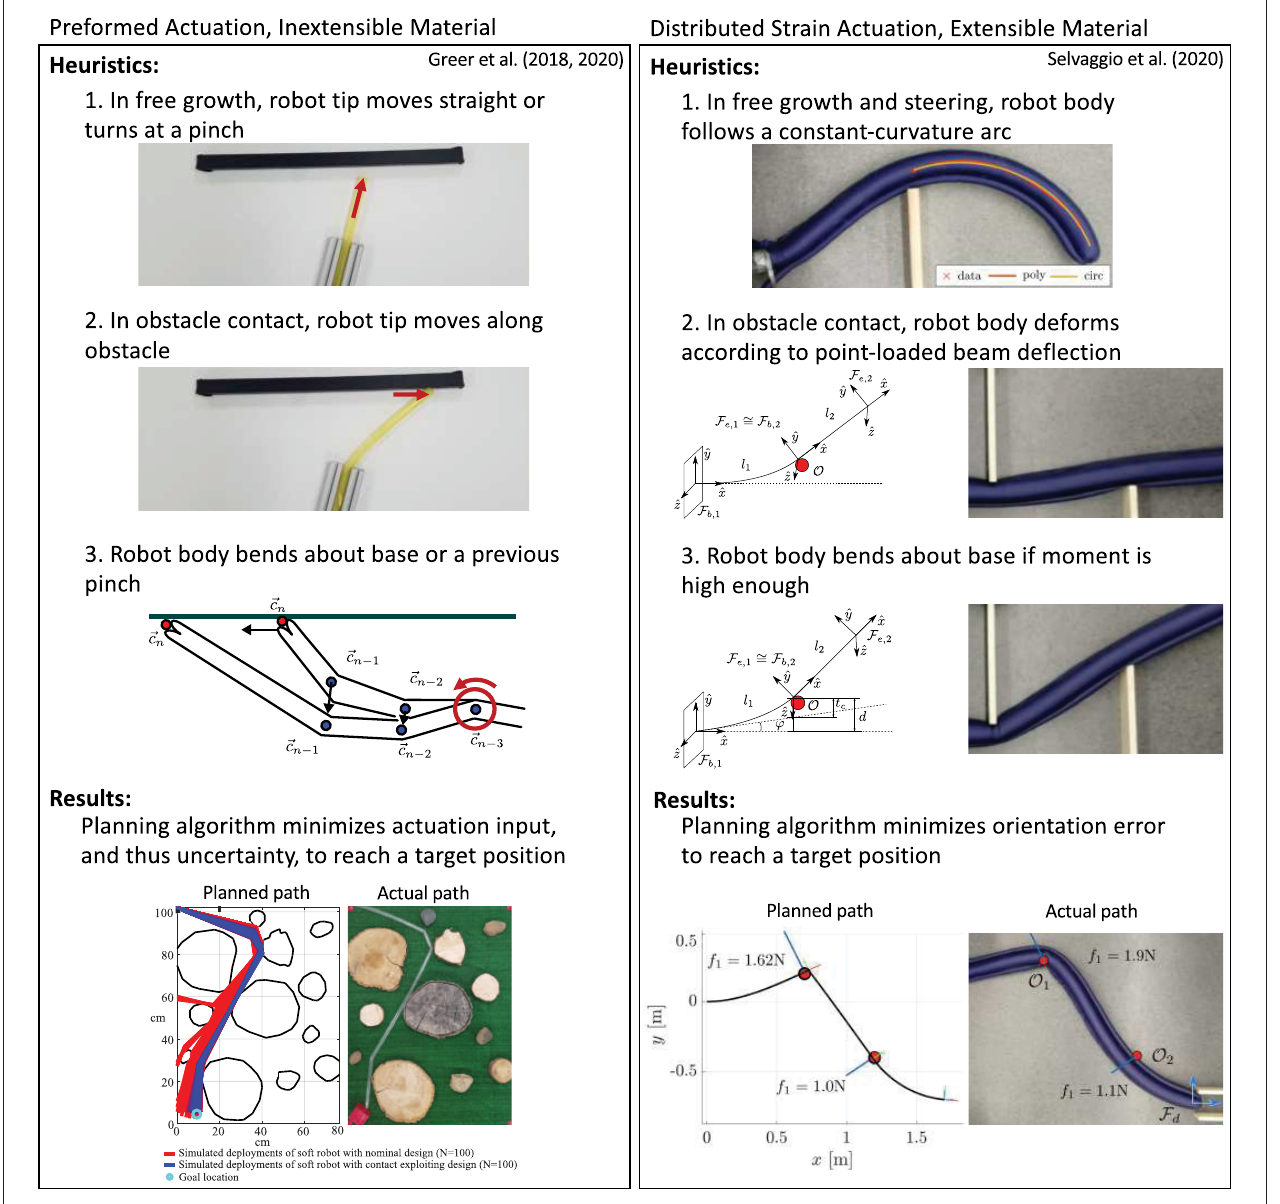
FIGURE 11 | Planning methods for (left) a preformed everting vine robot made of inextensible plastic and (right) an everting vine robot steered with distributed strain actuators and made of extensible fabric. The planning methods leverage heuristics about robot shape and environment interaction to minimize actuation input or orientation error while reaching a target position. Modified from Greer et al. (2020) and Selvaggio et al. (2020) © IEEE 2020.